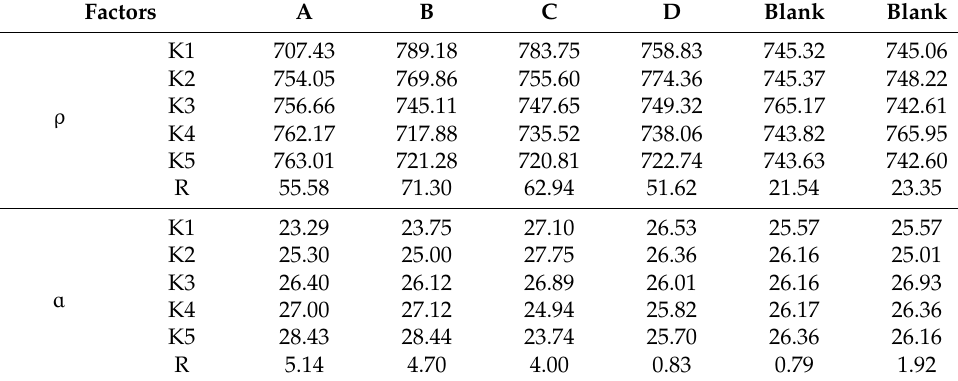
Table 4. Orthogonal test L 25 (5 6 ).